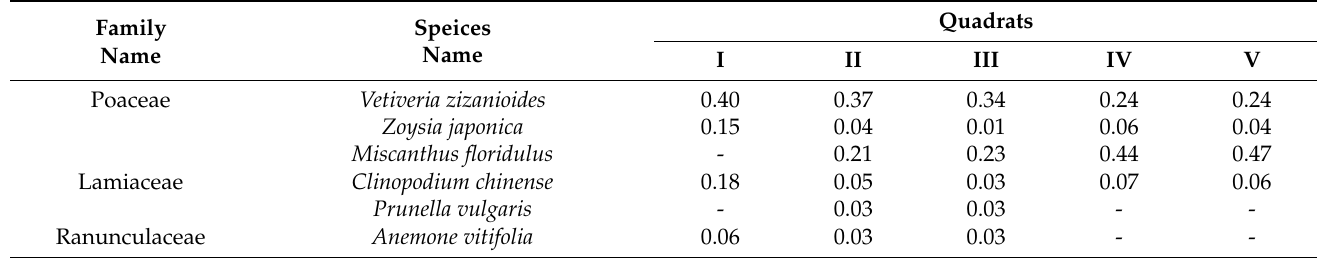
Table 3. Species importance value of quadrats in different coal gangue